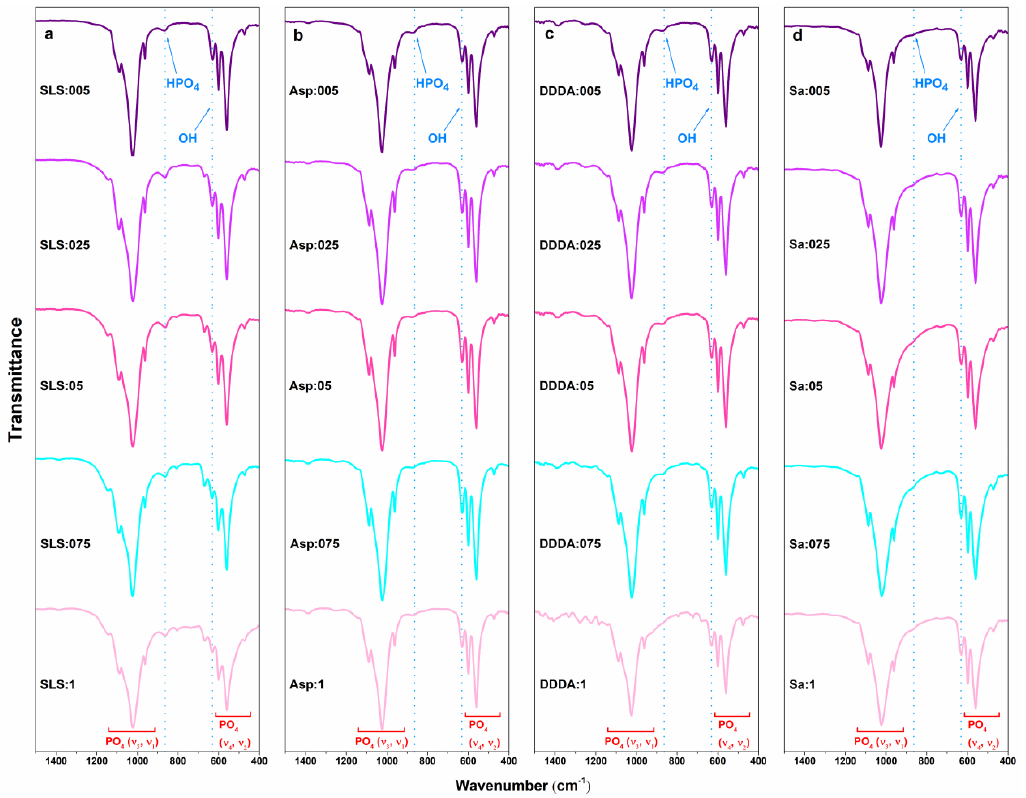
Figure 4. FTIR spectra of the samples prepared using various concentrations of SLS ( a ), DL-aspartic acid ( b ), dodecanedioic acid ( c ), and suberic acid ( d ) after a hydrothermal treatment at 200 °C for 5 h.